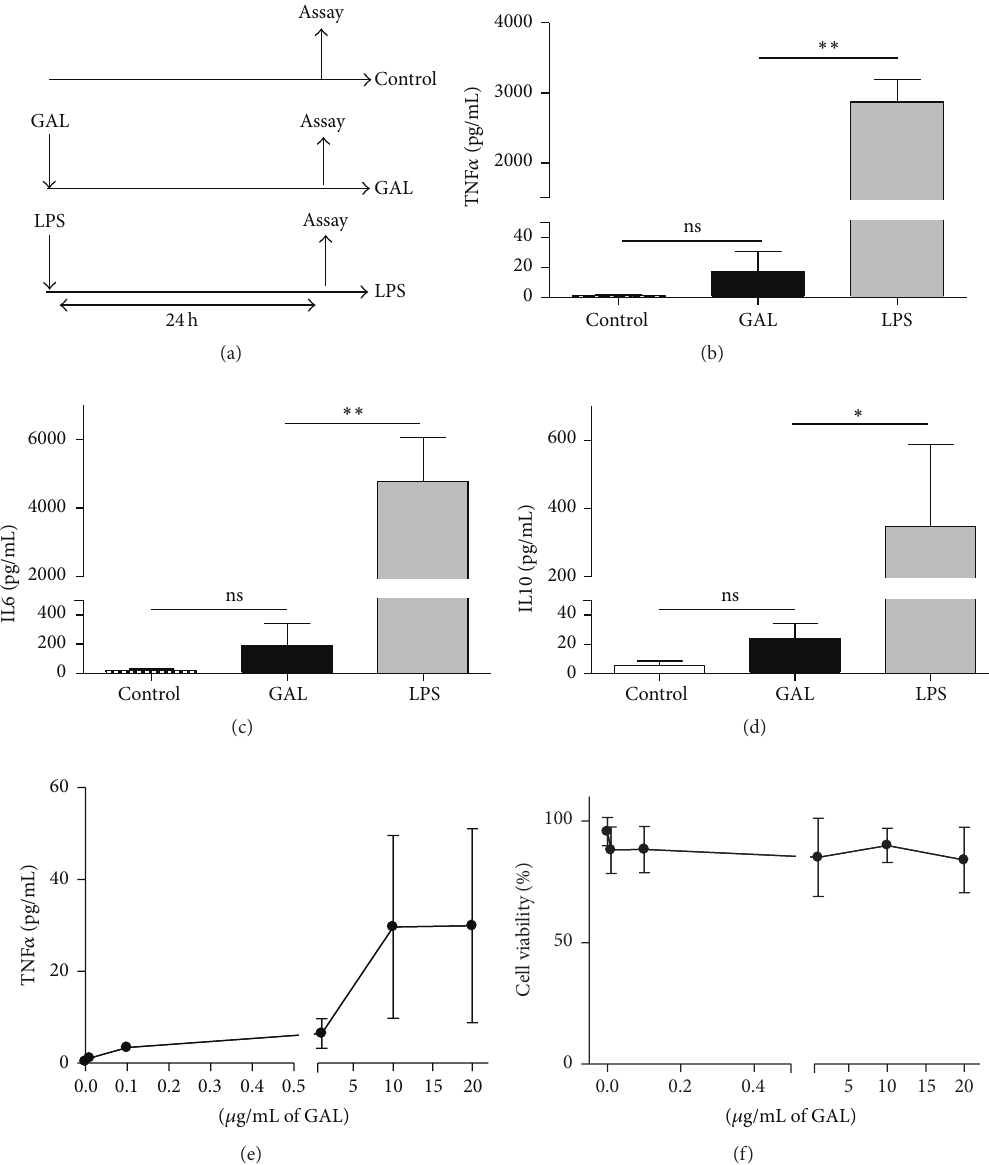
Figure 2: GAL is not able to induce an inflammatory response. (a) Schematic representation of the model used for this study. The cultures of human macrophages were treated with 10ng/mL LPS or 10 𝜇 g/mL GAL for 24 h. The controls were not treated. Supernatants were harvested and TNF 𝛼 (b), IL6 (c), and IL-10 (d) proteins levels were evaluated by CBA ( 𝑛 = 6 ); ∗ 𝑝 < 0.05 , ∗∗ 𝑝 < 0.01 compared with LPS. (e) The culture of human macrophages was treated with GAL at various concentrations for 24 h. Supernatants were harvested and the TNF 𝛼 protein levels were evaluated by CBA ( 𝑛 = 3 ). (f) The culture of human macrophages was treated with GAL at various concentrations for 24h. Cells were harvested, and intracellular cells stained with 7AAD were analyzed by flow cytometry. The 7AAD negative cells are represented (percentage of cell viability, 𝑛 = 4